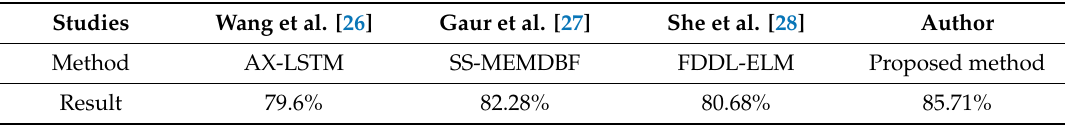
Table 4. Comparison of classification results for the proposed method with other published results applied on BCI competition IV dataset